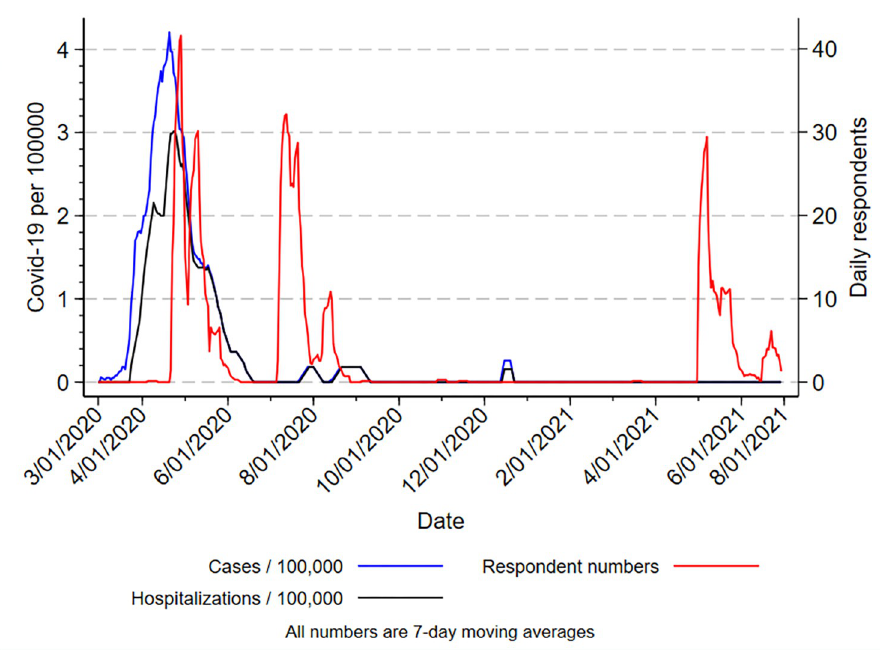
Fig 1. Relationship between dates of occurrence of COVID-19 cases and hospitalisations in Tasmania and numbers of responses during the three survey periods.